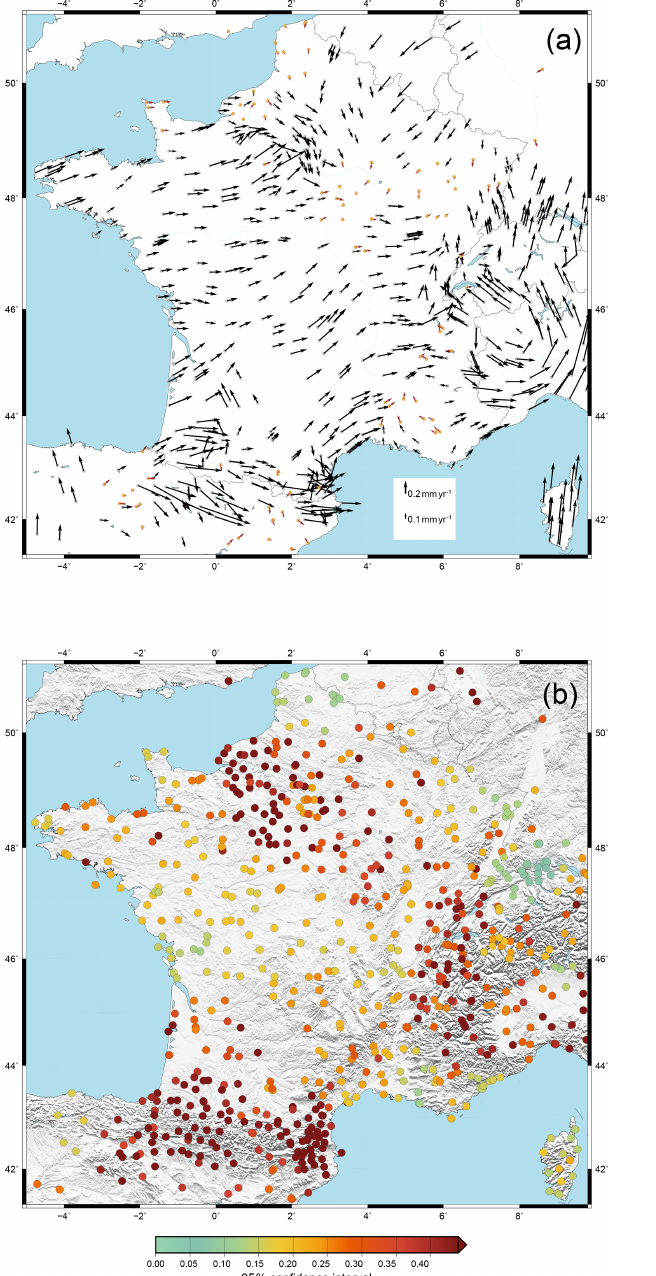
Figure 4. (a) Horizontal velocities from clustering with (b) 95% confidence interval (CI95). In brown: horizontal velocities below the detection level based on the synthetic dataset.